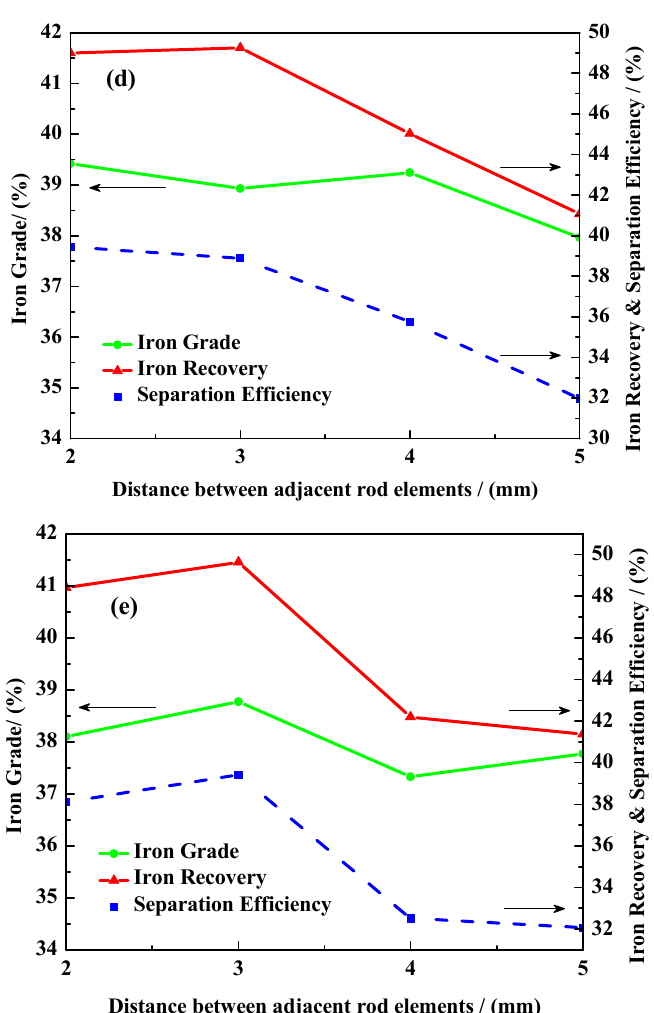
Figure 4. Influence of column gap between adjacent rod elements on the separation performance. The matrix radius is 3 mm, background magnetic induction is 0.8 T, the fluid velocity is 0.05 m/s, the length of stroke is 11.4 mm, and the frequency of pulsation is 30 Hz. ( a ) Distance between ERB p = 0 mm. ( b ) Distance between ERB p = 0.5 mm. ( c ) Distance between ERB p = 1.0 mm. ( d ) Distance between ERB p = 1.5 mm. ( e ) Distance between ERB p = 2.0 mm.